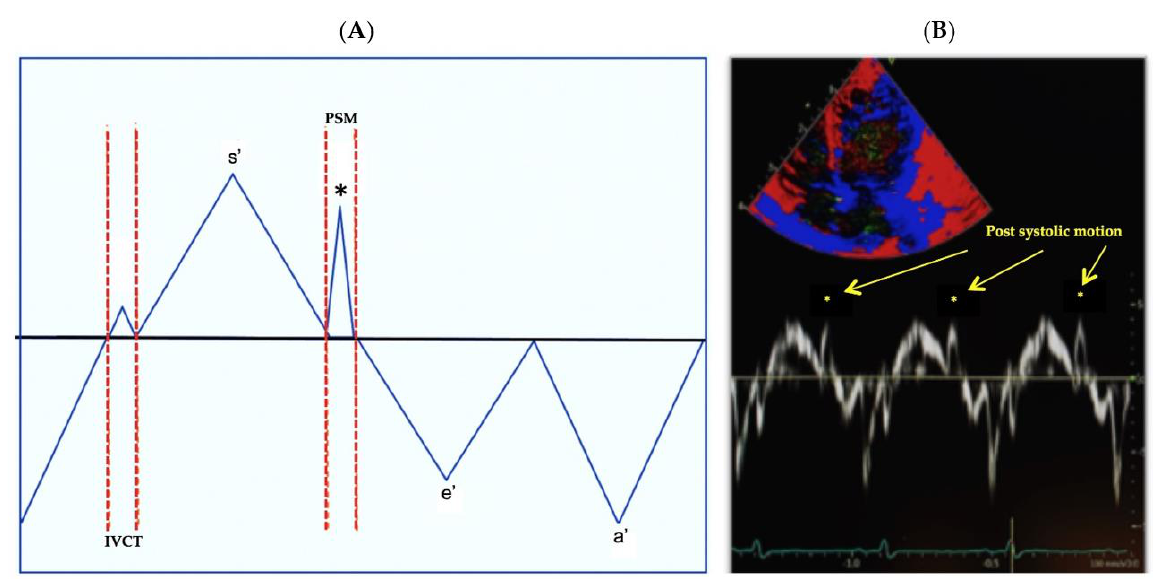
Figure 3. Post systolic motion (PSM) is denoted by the (*) and identified as a positive deflection on TDI occurring between the end of s’ and prior to e’. ( A ) Schematic representation. ( B ) TDI image.